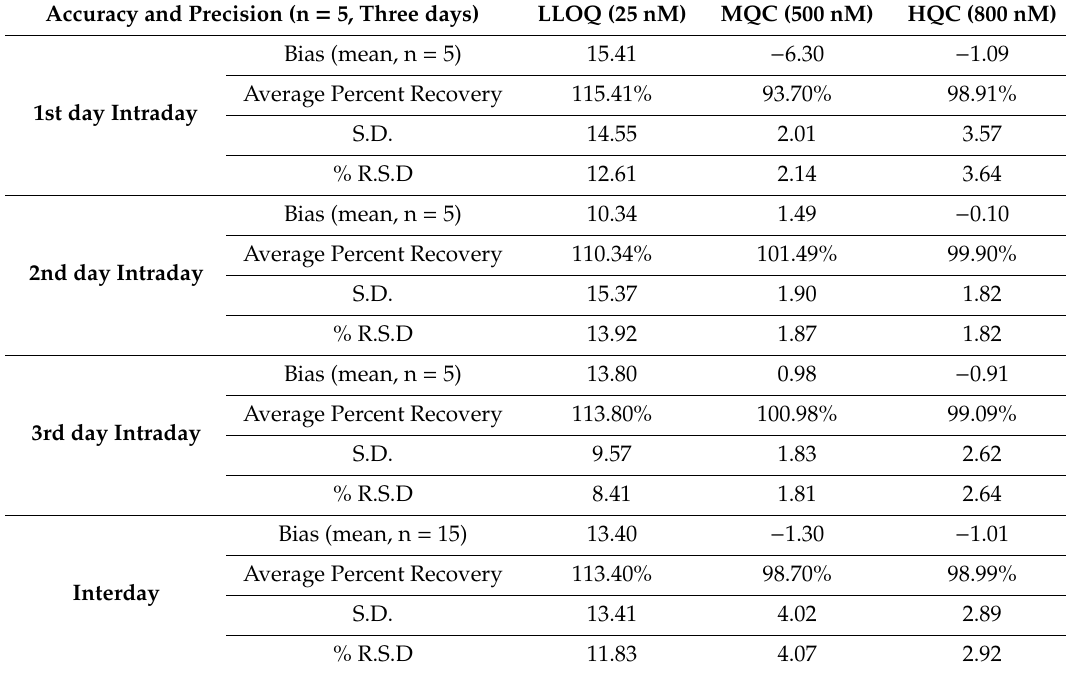
Figure 8. Multiple reaction monitoring (MRM) chromatogram of omarigliptin ( m / z = 399.2 to 153.0) and alogliptin (IS, m / z = 340.2 to 116.0) in human plasma sample obtained 1.5 h after oral administration of one Marizev ® tablet (12.5 mg).